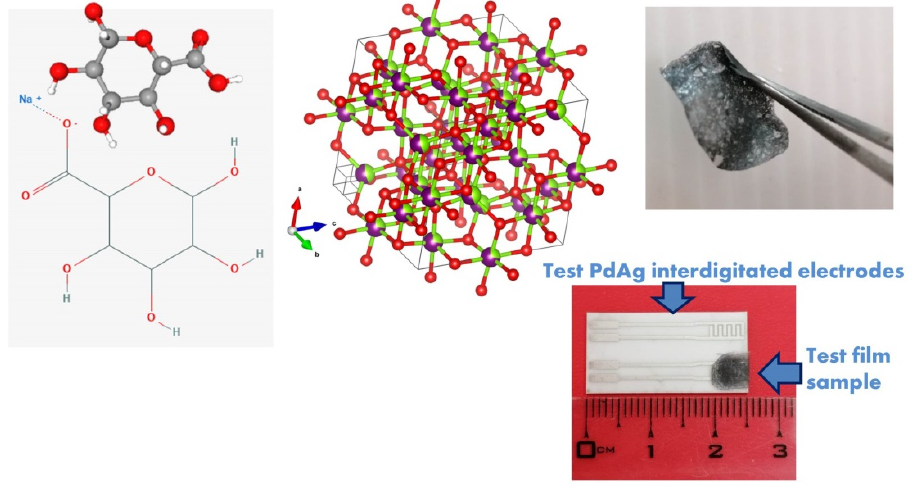
Figure 1. Nickel manganite (NiMn 2 O 4 )-sodium alginate nano-biocomposite film image ( upper right ); test interdigitated electrodes with and without film ( lower right ); crystal structure of NiMn 2 O 4 drawn using VESTA [30] ( center ); sodium alginate 2D and 3D structure images [31,32] ( left ).